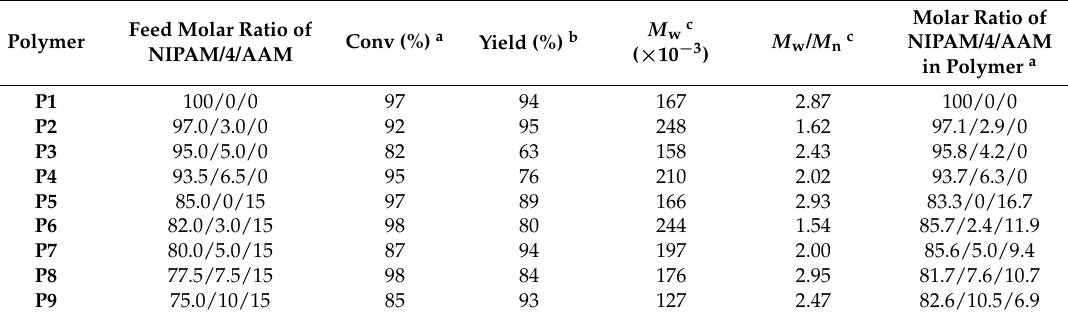
Table 1. Synthesis of copolymers bearing DB24C8.